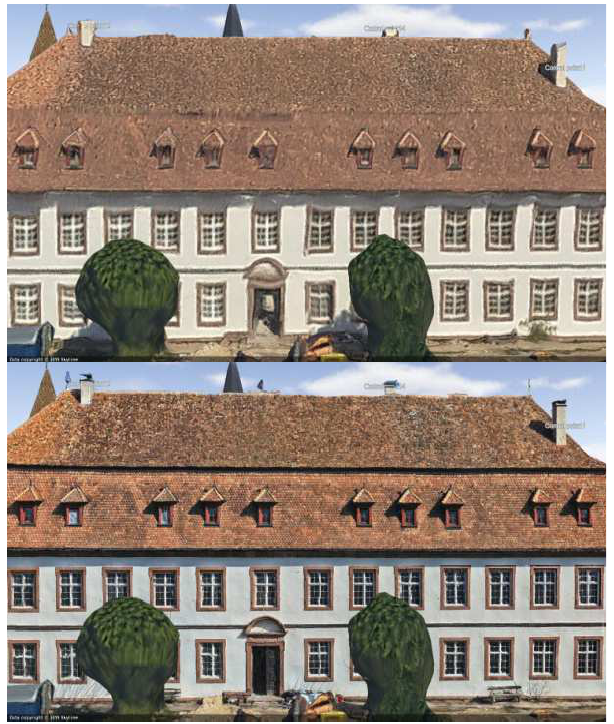
Figure 8 and 9: The aerial model above and the UAV model below of the southern facade of the Palais Stanislas